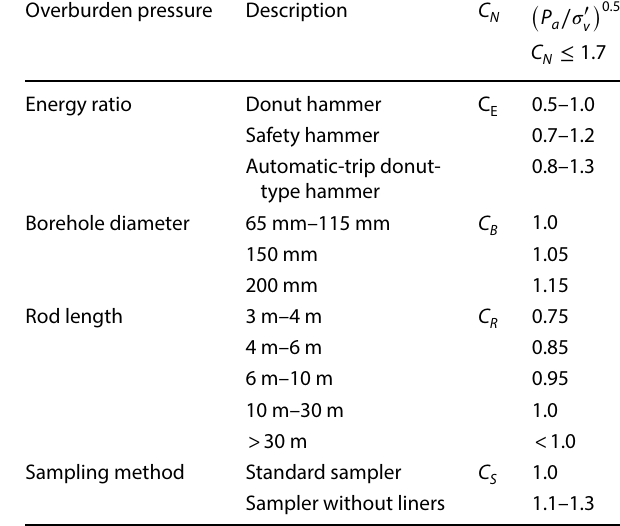
Table 2 Values of the correction coefficients of Eq. 5